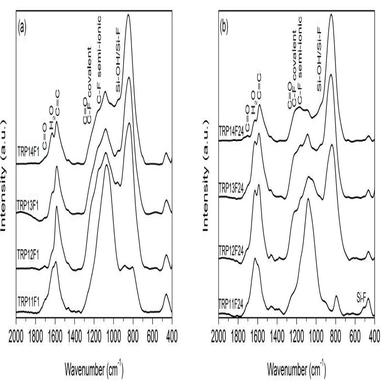
FT-IR spectra of TRF SiOC-CD materials etched during (a) 1 or (b) 24 h at different pyrolysis temperatures.